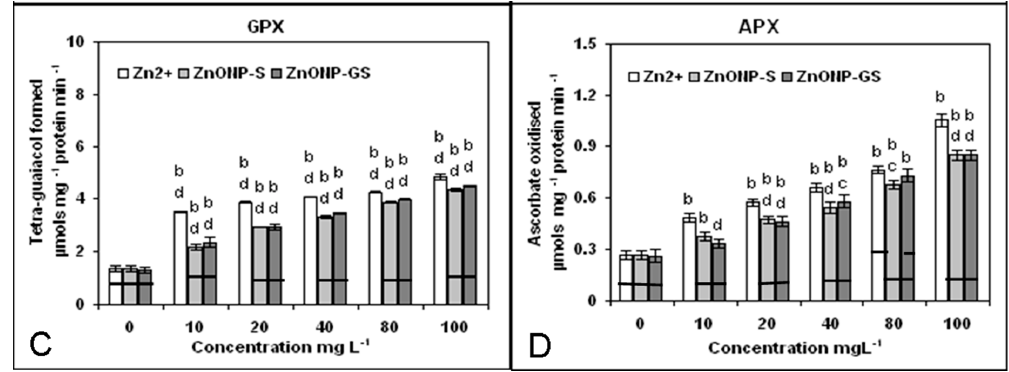
Figure 8. Activity of antioxidant enzymes ( A ) catalase (CAT), ( B ) superoxide dismutase (SOD), ( C ) guaiacol peroxidase (GPX), and ( D ) ascorpbate peroxidase (APX) in the root tissue of germinating seeds of C. gigantea treated with Zn 2+ or ZnONPs at different concentrations (0–100 mg L − 1 ). Increase significant at p ≤ 0.05 (a) or 0.01 (b) compared to the control (0), and decrease significant at p ≤ 0.05 (c) or 0.01 (d) compared to Zn 2+ . The horizontal bar denotes no significant difference between the treatments at p ≤ 0.05, ( n = 6).